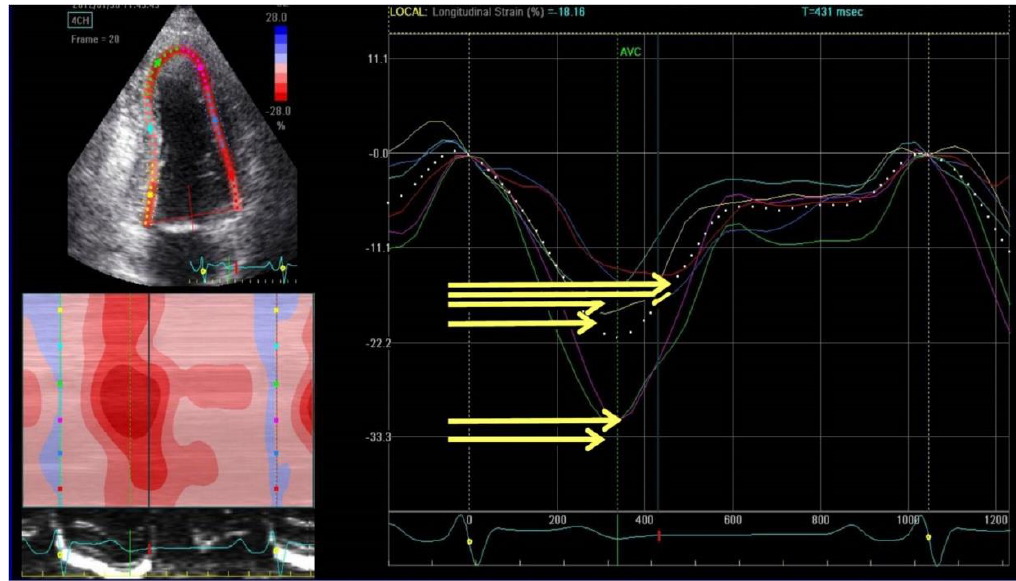
Figure 3. Evaluation of mechanical dispersion by speckle tracking echocardiography. Mechanical dispersion is calculated as the standard deviation of time to peak regional negative strain (yellow lines).